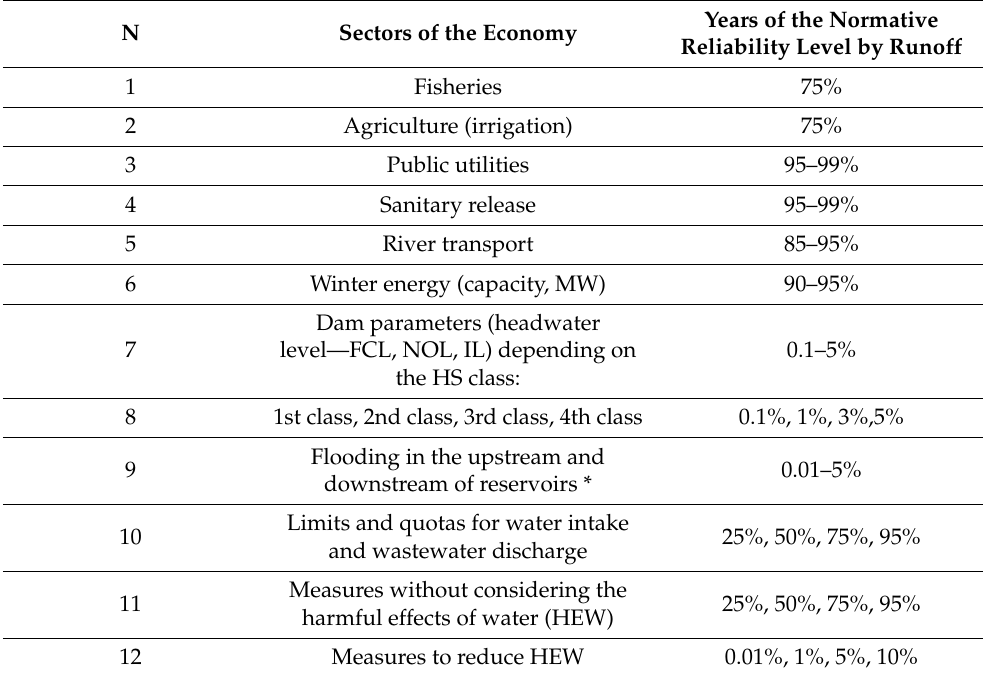
Table 1. Normative reliability levels for various sectors of the